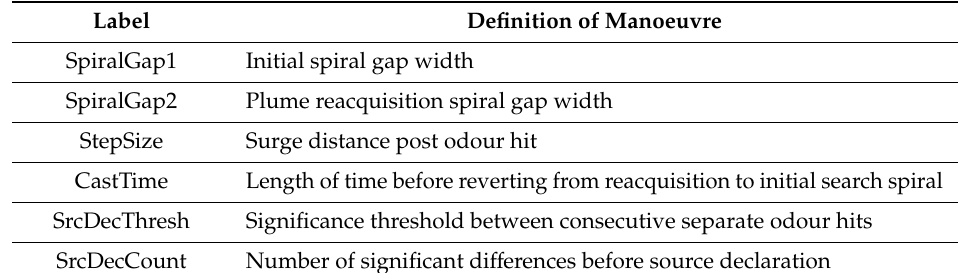
Table 11. List of individual parameters of the Spiral Surge (SS) algorithm, developed from information in